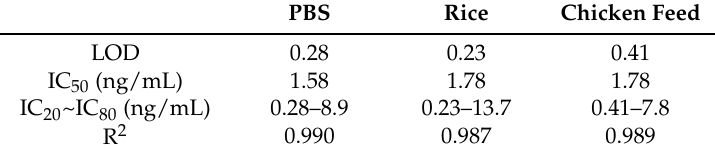
Table 1. LOD, IC 50 , IC 20 –IC 80 and R 2 of T-2 in PBS, rice and chicken feed by FMs-LFIA.